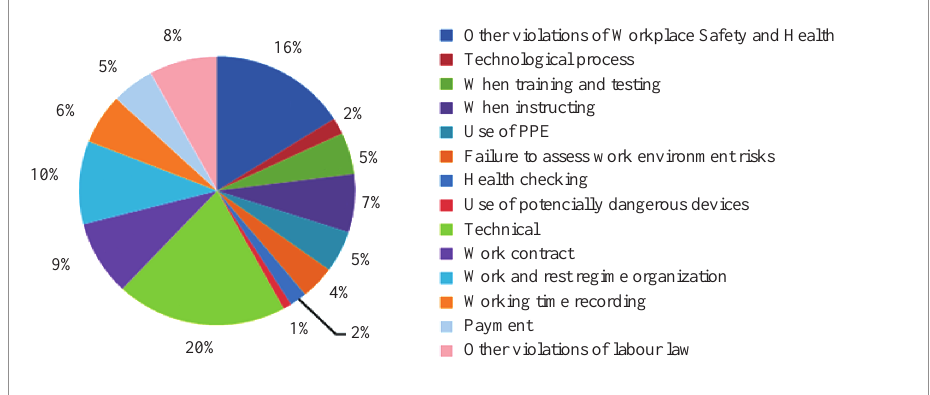
Fig. 3. The structure of legal act violations in